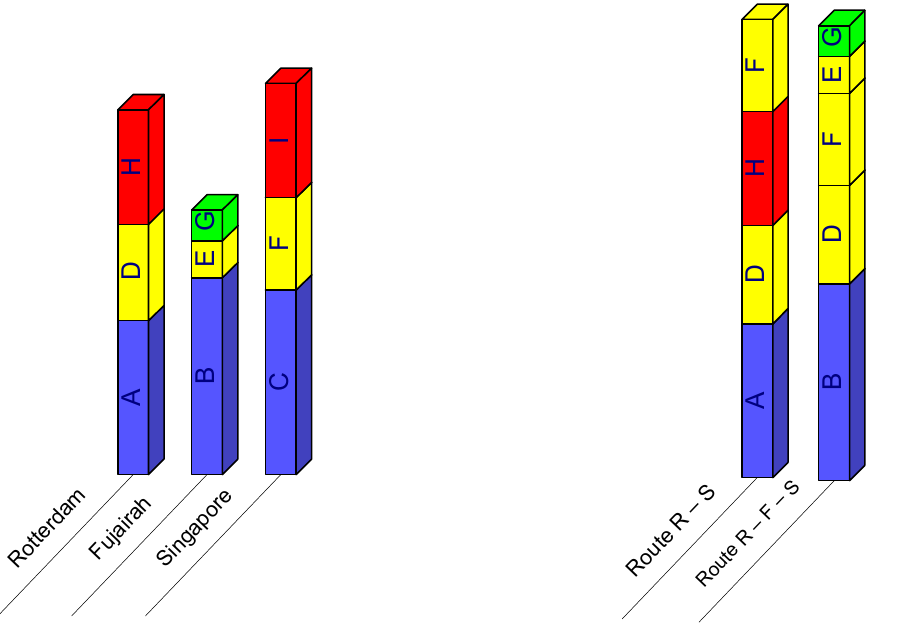
Figure 2. Illustrative maximum costs per port (left) and per shipping route (Right). A, B and C are bunker costs, D, E and F are port dues, G is costs for extra nautical miles of sailing, H, I tax on